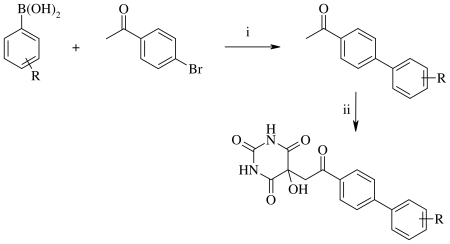
Synopsis of the synthesis of compounds 3–9 in
Figure 1
.Reagents and conditions: (i) Na2CO3, (PPh3)2PdCl2, water/dioxane, microwave heating; (ii) alloxan monohydrate, acetic acid, reflux.